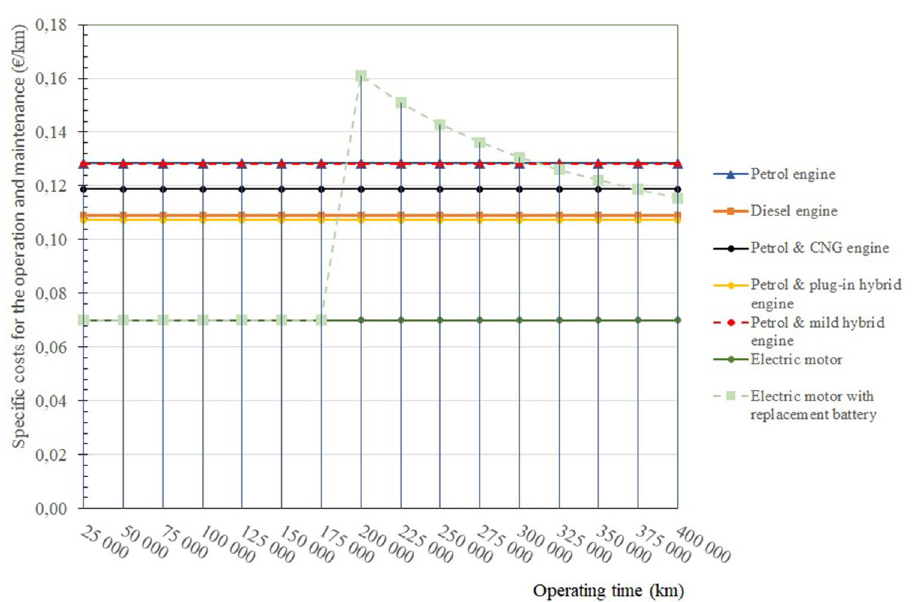
Figure 9. Specific life cycle ownership costs for the operation and maintenance of selected passenger car